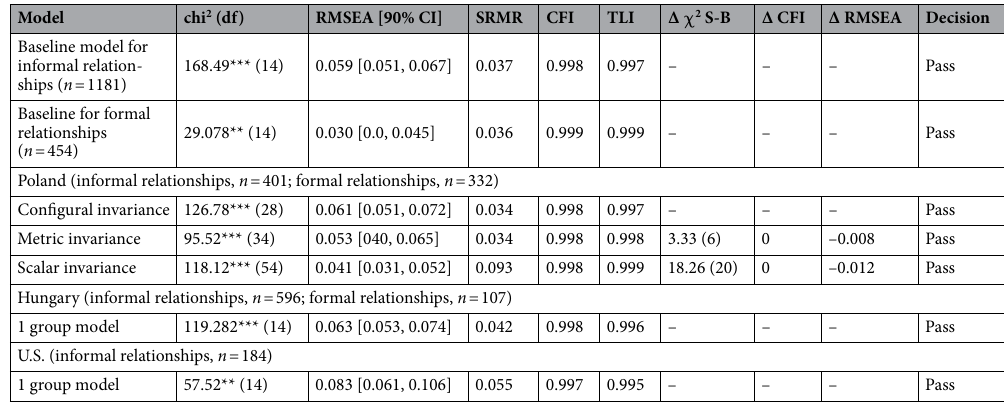
Table 4. Model Fit for Multiple Groups by the Relationship Type Models and Measurement Invariance Comparisons. CFI comparative fit index, TLI Tucker–Lewis index, RMSEA root mean square error of approximation, CI confidence interval, df degrees of freedom, SRMR squared root mean residuals, S–B Satorra– Bentler correction, Δ comparisons of nested model: configural-metric, metric-scalar. * p < 0.05, ** p < 0.01, ***p < 0.001.